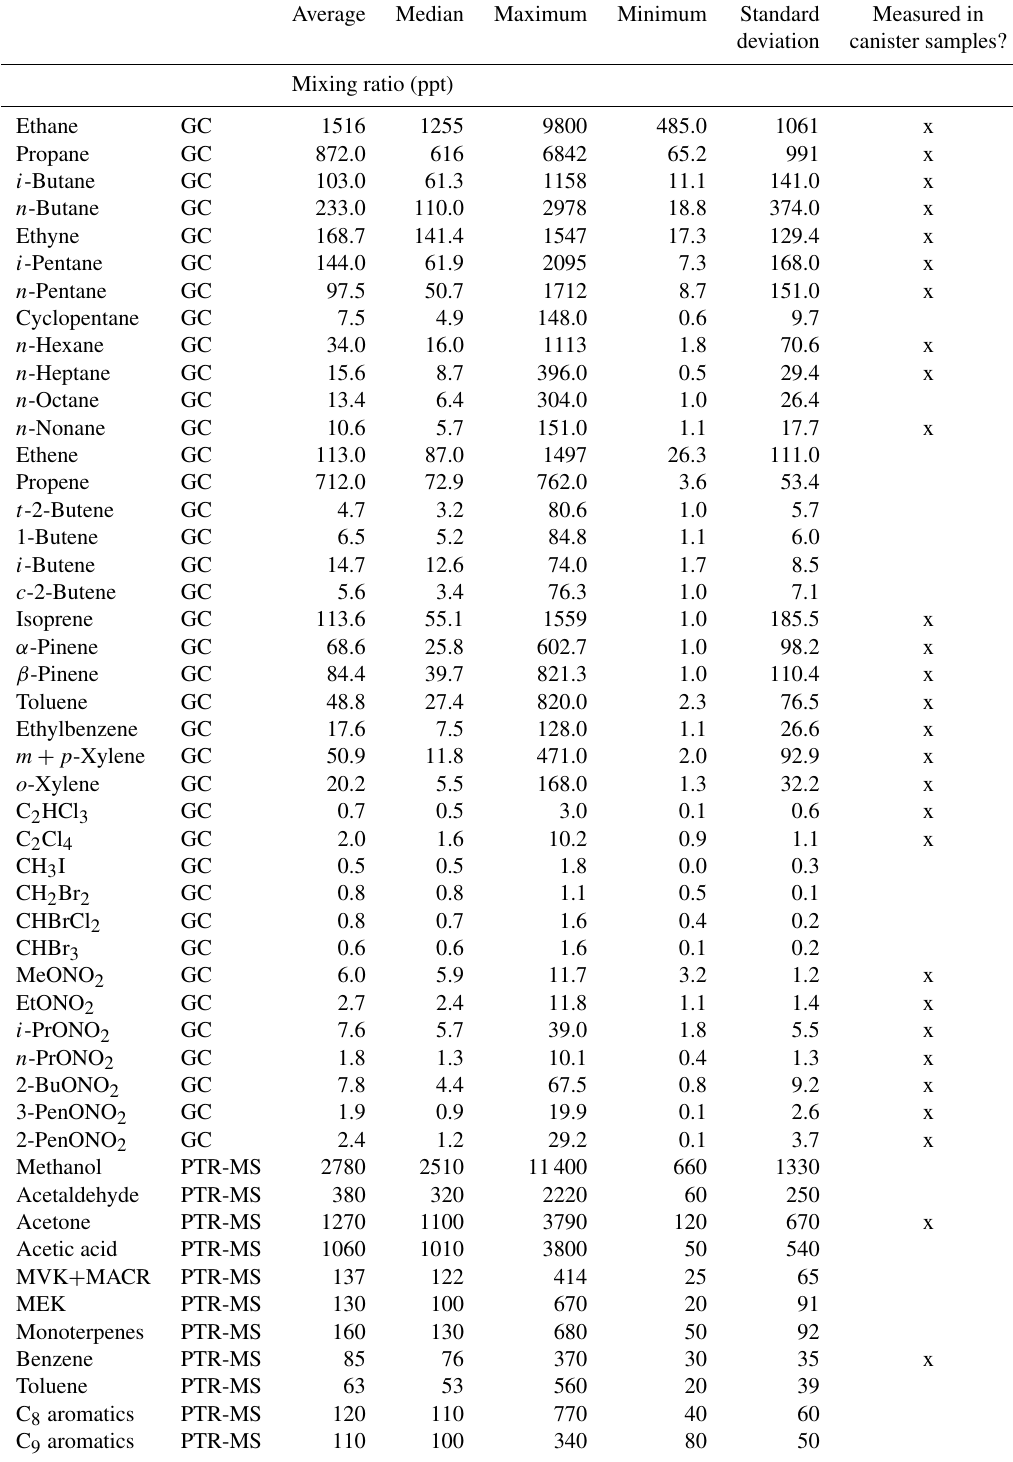
Table 1. VOCs measured using the in situ GC system and PTR-MS at ROMO-LP. Also denoted are gases reported from the transect canister samples. Statistics are given for the GC and select PTR-MS